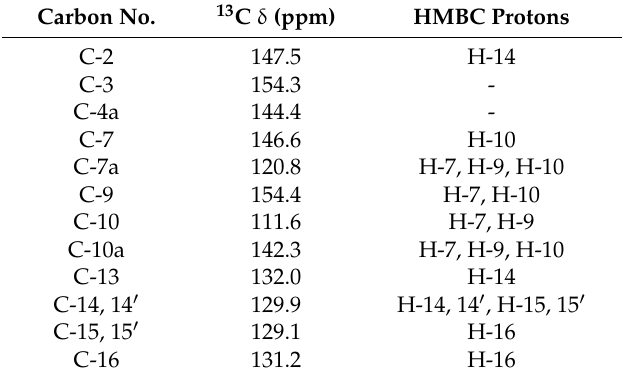
Table 3. 13 C-NMR data for 7 with long-range C/H couplings observed in HMBC spectrum.